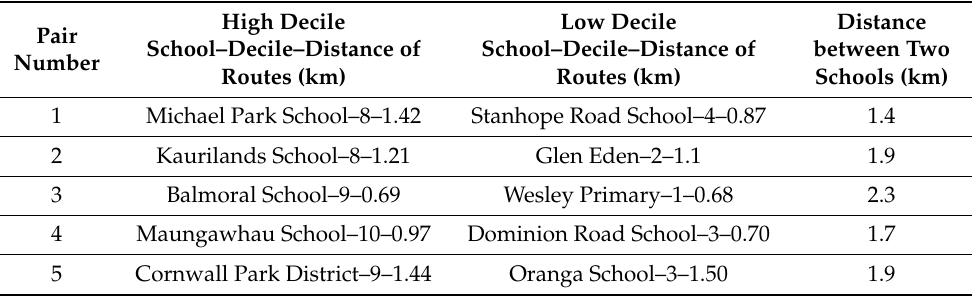
Table 1. The selected pairs of primary schools, their decile, the distances of the school routes for each school, and the distance between the schools in each pair. High Decile Pair School–Decile–Distance Number